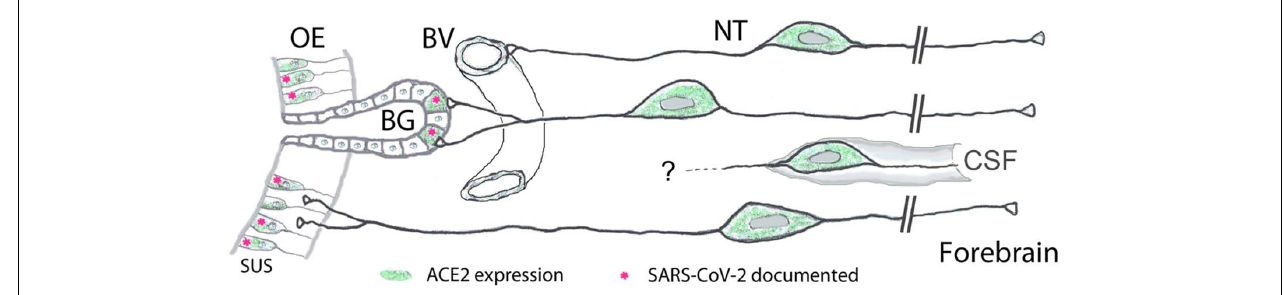
FIGURE 4 | Peripheral projections of nervus terminalis (NT) neurons and their presumptive relationship with ACE2-expressing neurons in the olfactory epithelium and known SARS-CoV-2 infection. NT neurons innervate blood vessels (BV), Bowman gland (BG) cells, the olfactory epithelium (OE), and contact cerebrospinal fluid (CSF) spaces. Peripheral projections of NT neurons according to Larsell (1950), CSF contacts according to Jennes (1987). Cells expressing ACE2 are indicated in green, including sustentacular cells (SUS) and BG cells. Both of these cell types have been shown to express ACE2 (Bilinska et al., 2020; Brann et al., 2020; Chen et al., 2020; Ye et al., 2020; Zhang et al., 2020; Klingenstein et al., 2021). Cell types that have been documented to be infected by SARS-CoV-2 are indicated with pink asterisks. SARS-CoV-2 localization in SUS cells according to Bryche et al. (2020); Leist et al. (2020), Ye et al. (2020); Zhang et al. (2020), Zheng et al. (2021); de Melo et al. (2021), and in BG cells according to Bryche et al. (2020); Leist et al. (2020), and Ye et al. (2020). BG cells furthermore express the protease furin (Ueha et al., 2021) which may facilitate virus entry into those nervus terminalis neurons which innervate BG cells.